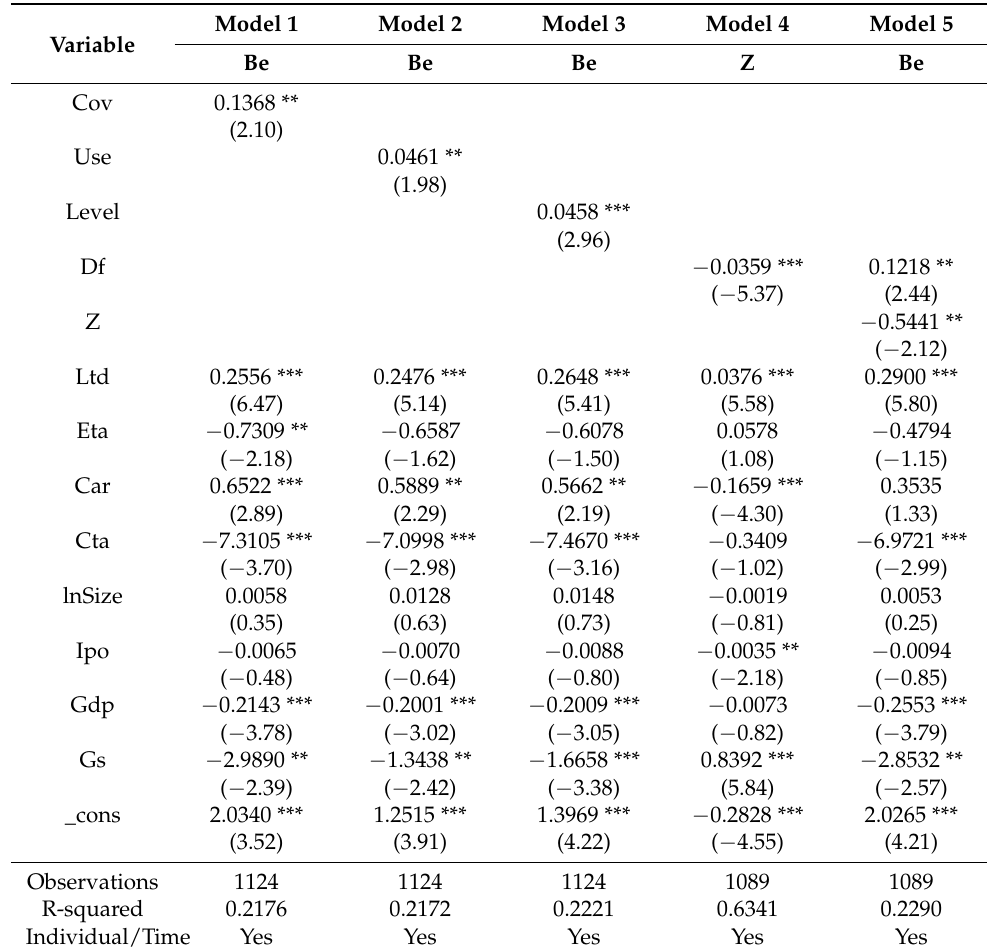
Table 7. The regression of replacing the